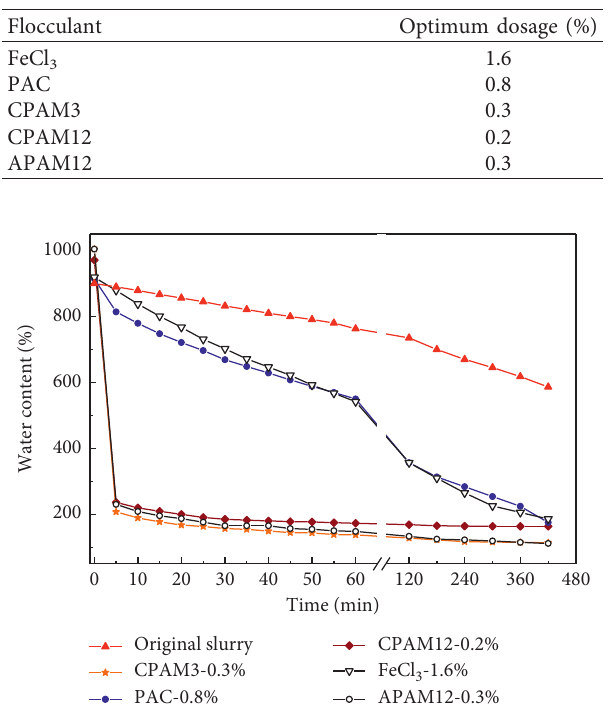
Figure 7: Water content curve of sediment using different